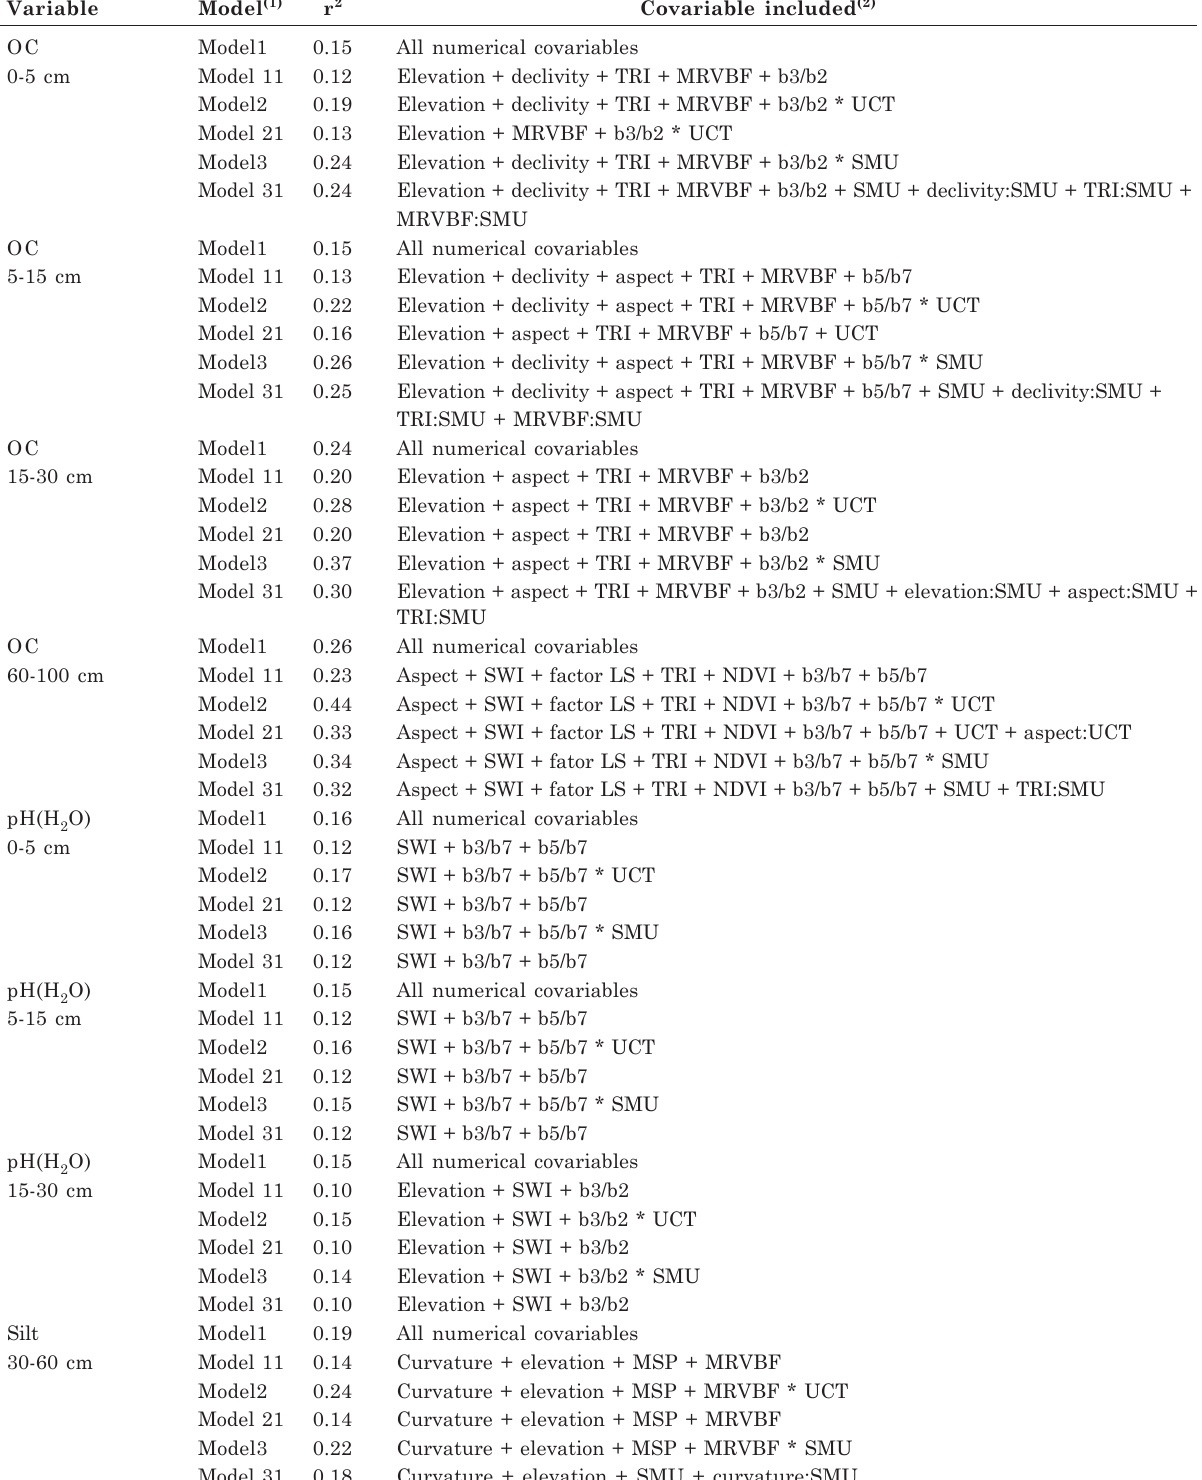
Table 5. Evaluation results of the MLR models by the introduction of categorical covariates for the functions “update” and “stepwise” of